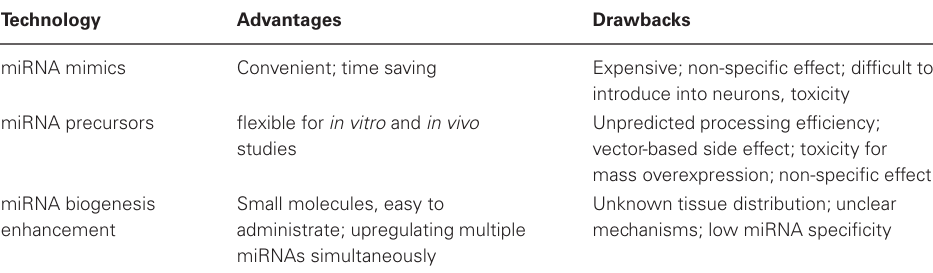
Table 1 | Advantages and drawbacks of miRNA gain-of-function